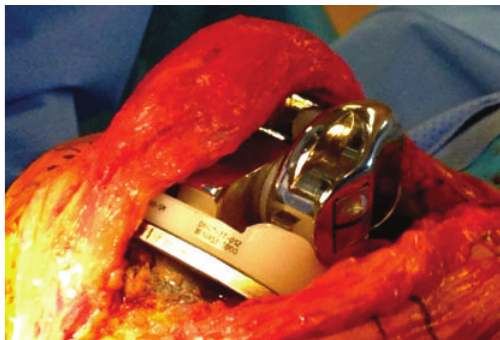
Figure 3: Intraoperative illustrating new tibial hinge insert, hinge pin, and locking